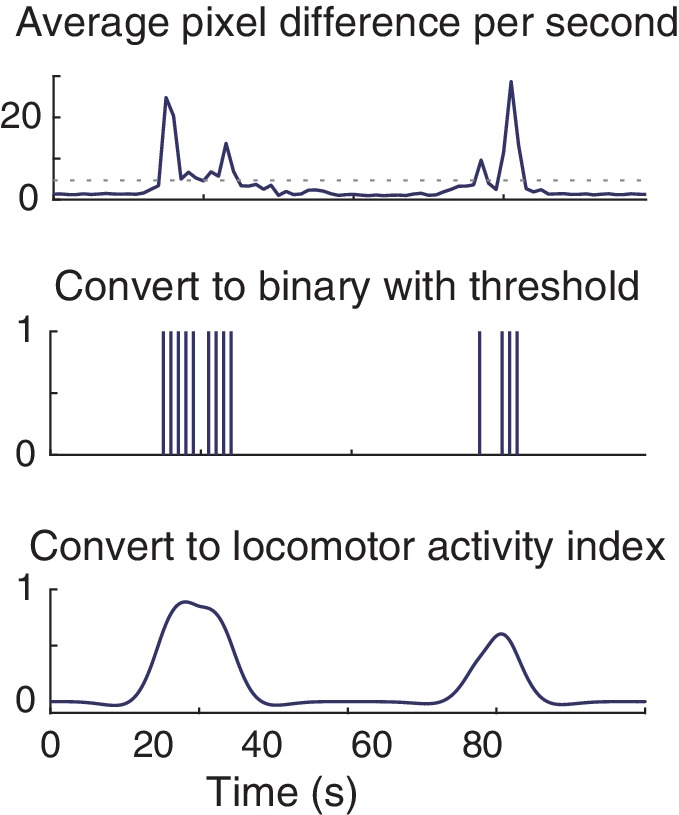
Measurement of locomotor activity.Illustration showing how the continuous measure of body movement, or ‘locomotor activity’, was calculated for each session. Average pixel differences were taken between adjacent video frames in each observational session. A 90% threshold was used to convert average pixel differences to binary immobile-mobile values and smoothed with a spline (smoothing parameter of 0.10).